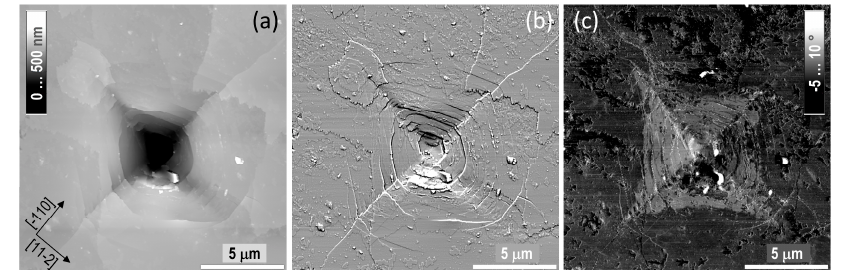
Figure 2. AFM images of a Vickers indent (5-N load) on the (111) synthetic diamond: ( a ) topography; ( b ) derivative topography; and ( c ) phase contrast.